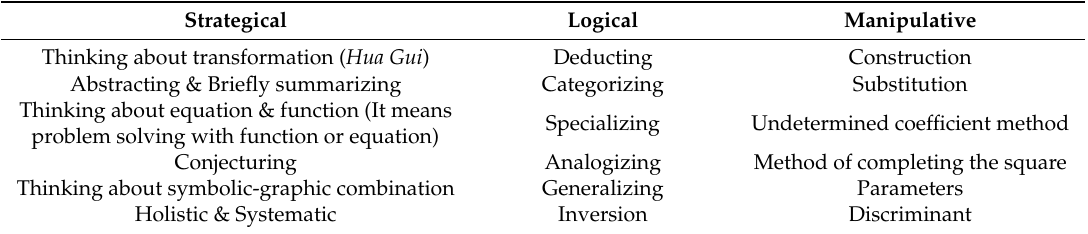
Table 3. Types of mathematical thinking in junior secondary education by analyzing